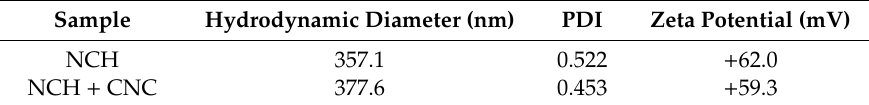
Table 1. Digital Light Scattering (DLS) measurement.